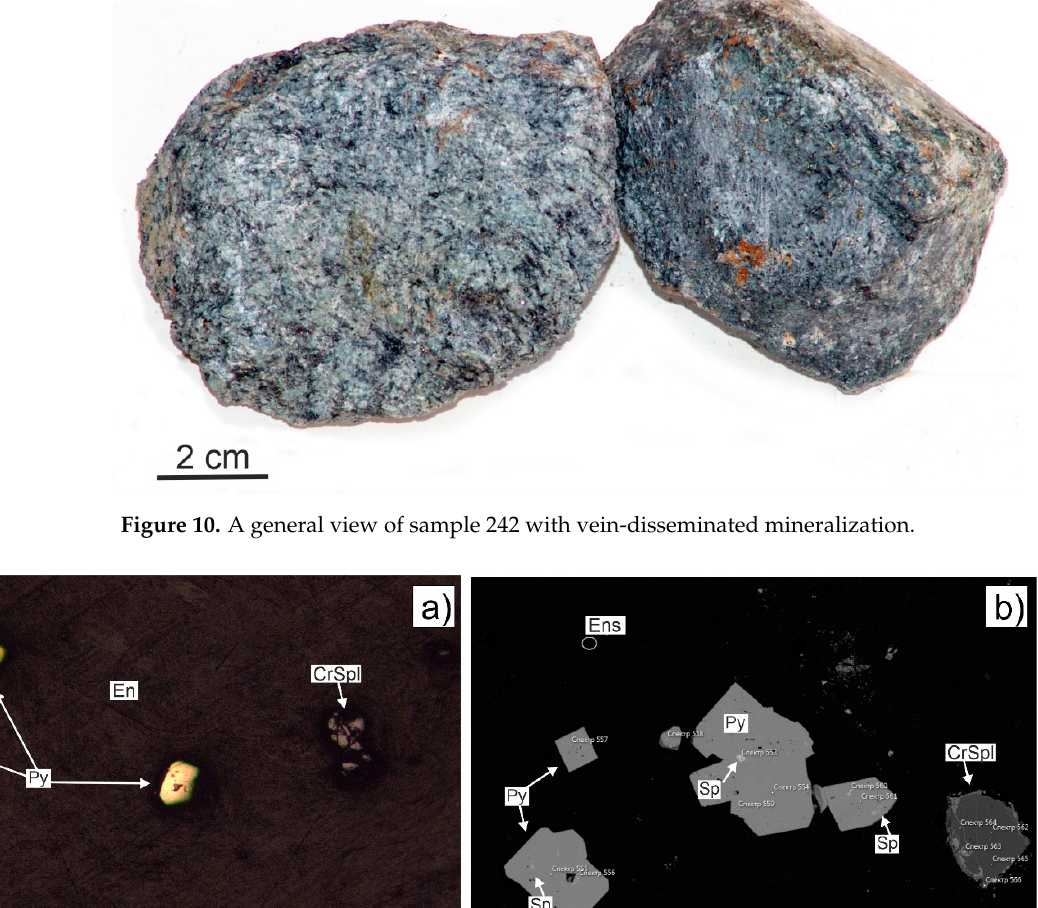
Figure 9. Porous Cr ‐ spinels in sulfide sample 242 ‐ 2. BSE images. ( a ) Acute ‐ angled fragments of Cr ‐ spinels in porous pyrite. ( b ) Acute ‐ angled grain of Cr ‐ spinels. The vein ‐ disseminated mineralization in sample 242 is represented by thin quartz ‐ pyrite and pyrite veins (Figure 10), as well as dissemination of pyrite, pyrite ‐ sphalerite intergrowths and Cr ‐ spinels in hydrothermally altered ultramafic rock (Figure 11). Cr ‐ spinels have a border rim differing in color and composition. The chemical composition of minerals is represented in Table 4. Based on microprobe analysis, the altered ultramafic rocks are made up of enstatite (MgO = 31.5%, SiO 2 = 65.3%, Fe 2 O 3 = 3.2%).